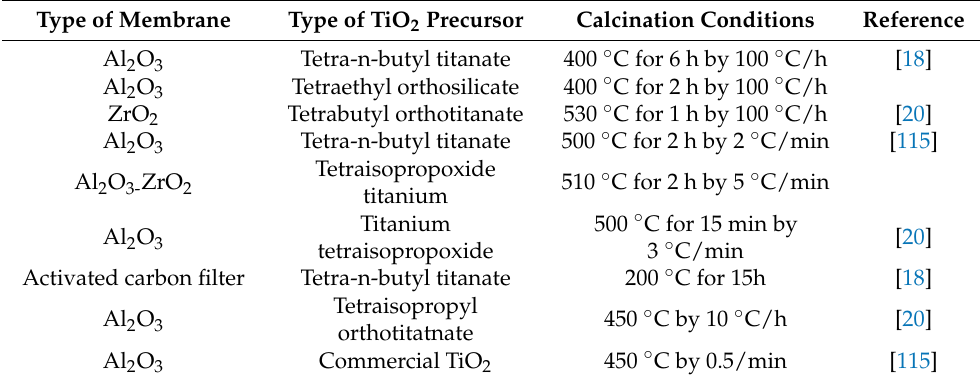
Table 5. Synthesized TiO 2 ceramic